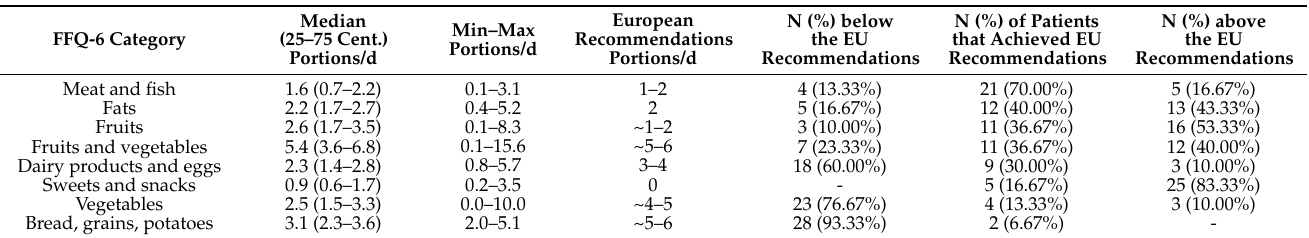
Table 2. Characteristics of the Food Frequency Questionnaire 6 (FFQ-6) responses according to WHO food-based dietary guidelines and WHO sugar intake for adults and children guidelines.